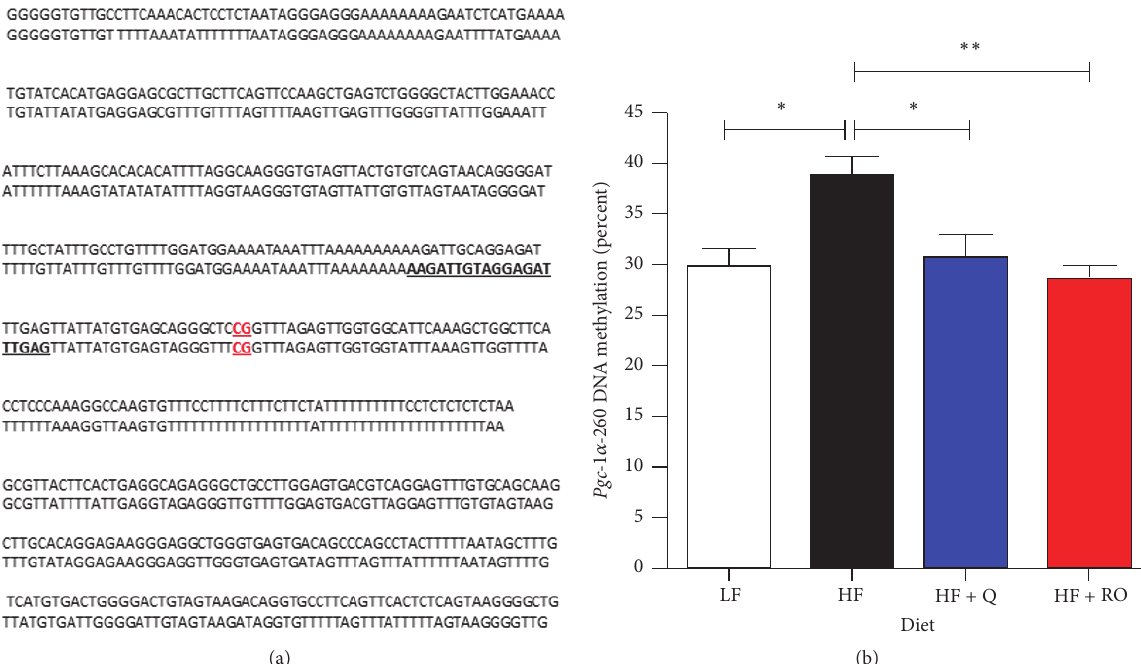
Figure 4: Bisulfite sequencing of the Pgc-1 𝛼 promoter was used to determine DNA methylation levels at the − 260nt. The original (top line) and bisulfite converted (corresponding bottom line) sequences are shown in (a). The bold and underlined region within the bisulfite converted sequence indicates where the pyrosequencing primer is located. The red highlighted, bold, and underlined region is the regulatory − 260 nt that undergoes DNA methylation. The percent of DNA methylation present at the − 260nt in skeletal muscle is shown as the mean ± SEM for low fat (LF), high fat (HF), high fat plus quercetin (HF + Q), and high fat plus red onion extract (HF + RO) animals after 9wks of feeding the respective diets. ∗ denotes significant difference with P < 0.05 and ∗∗ P <